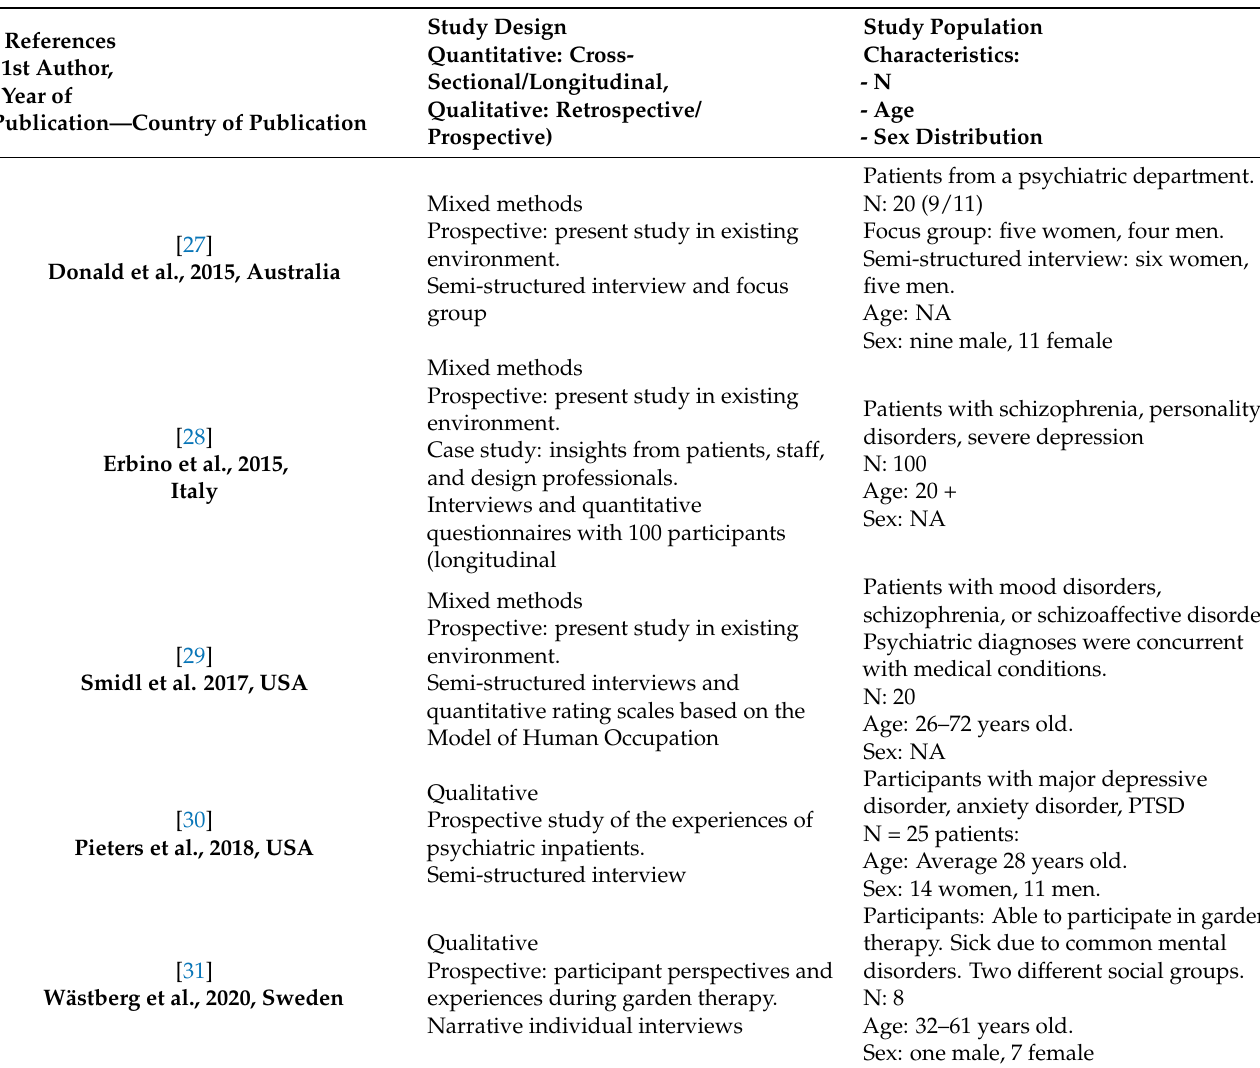
Table 3. Table 2. Overview of study